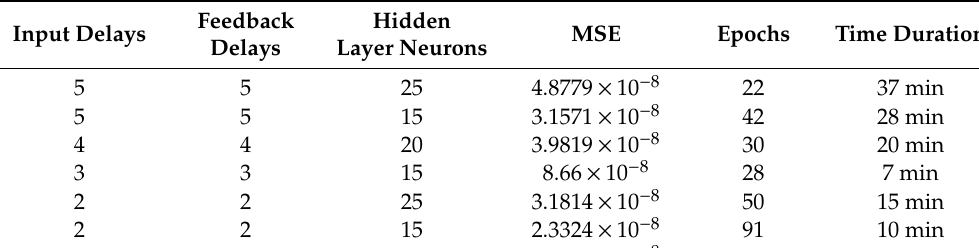
Table 3. RNARXNN results for di ff erent delays and hidden layer neurons.